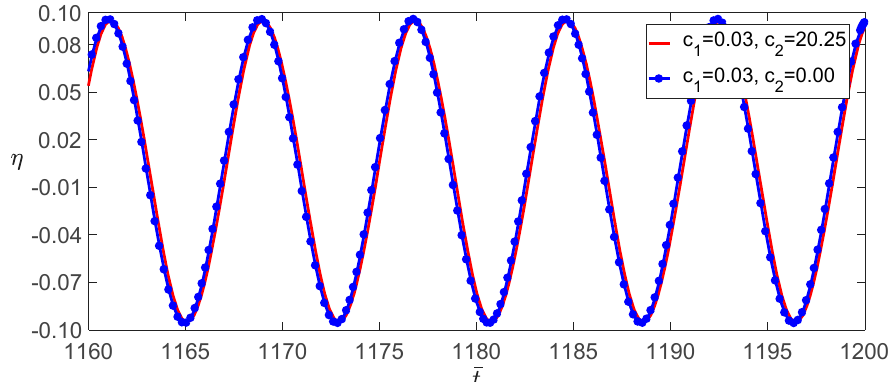
Figure 7. Time evolution of the microbeam’s midpoint displacement of primary resonance for f 2 = 3 and σ = 10 .